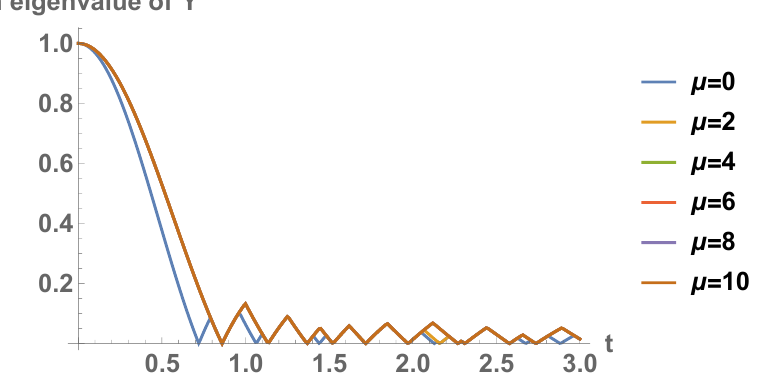
Figure 6 . The smallest eigenvalue of the super-operator Y µ for the N = 6 free fermion model for various µ with the various ω equal to 2.06238, 1.59206, and 0.703448. The plots for µ > 2 overlap for nearly all of the displayed values of t